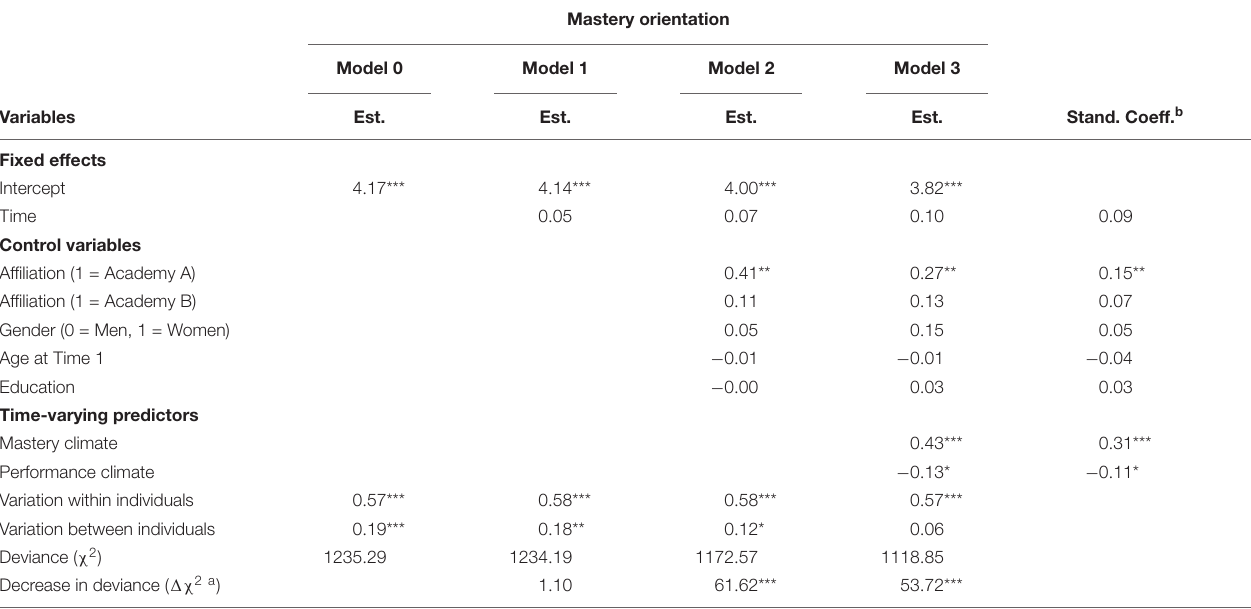
TABLE 2 | Results of multilevel analysis.